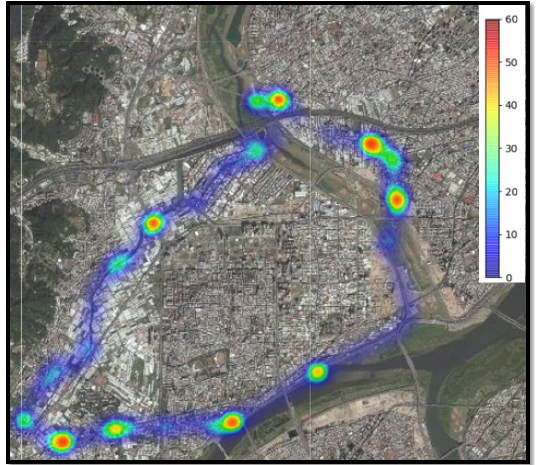
Figure 25. Prediction results for 11:00 P.M. on 14 February 2019.